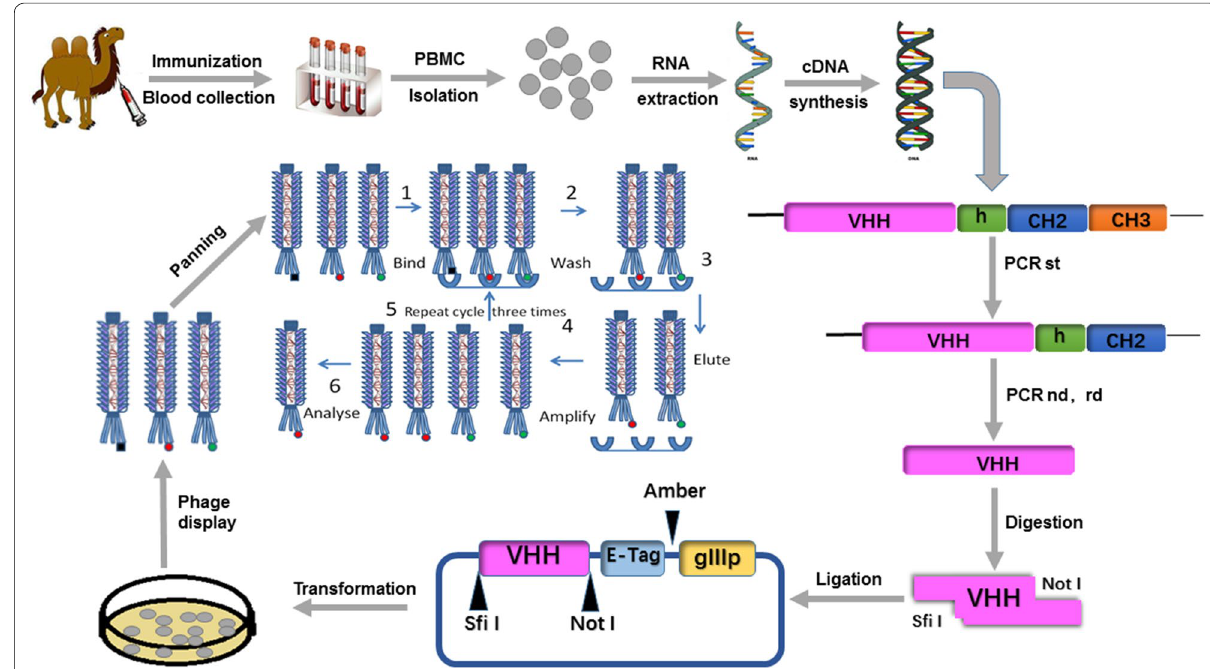
Fig. 2 Schematic diagram of the construction and screening of a single-domain phage display library. Peripheral blood mononuclear cells (PBMCs) were isolated from the blood samples of a Bactrian camel immunized with PEDV, and total RNA was extracted from the PBMCs and reverse transcribed to cDNA. The VHH gene fragments with restriction enzyme sequences were amplified with nested PCR. In the first round of PCR, the gene fragment (~ 600 bp) containing the VHH, hinge region and CH2 domain was amplified from the cDNA, and then the VHH gene was amplified by a pair of primers specific for VHH gene FR1 to FR4 using the product of the first PCR (600 bp product). Sfi I and Not I restriction sites were added on the third round of PCR. The VHH gene was ligated into the pCANTAB 5E plasmid and transformed into E. coli TG1, and after rescue by the M13K07 helper phage, the VHH gene was displayed on the phage surface. The PEDV spike protein-specific phages were enriched by three rounds of